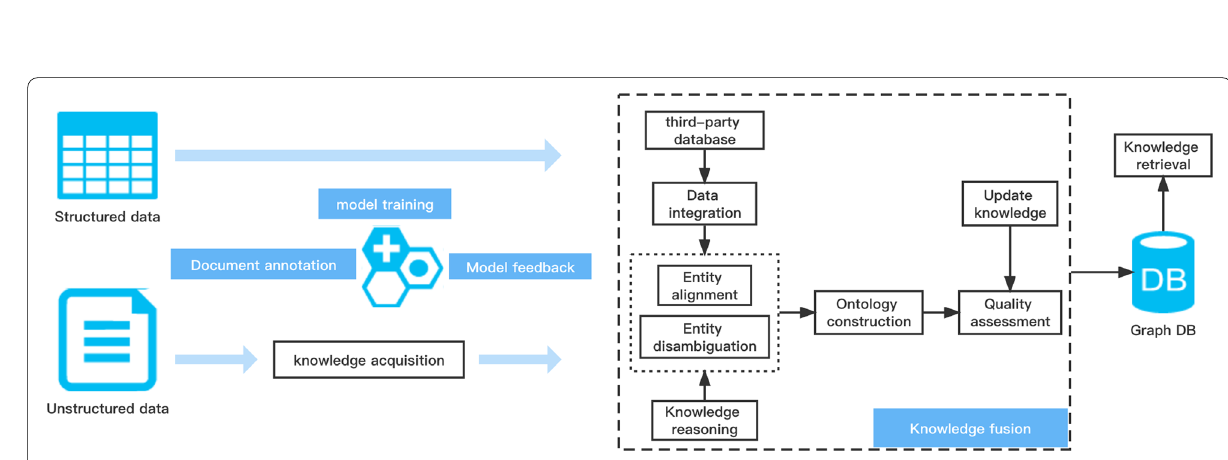
Fig. 5 Defect KG construction